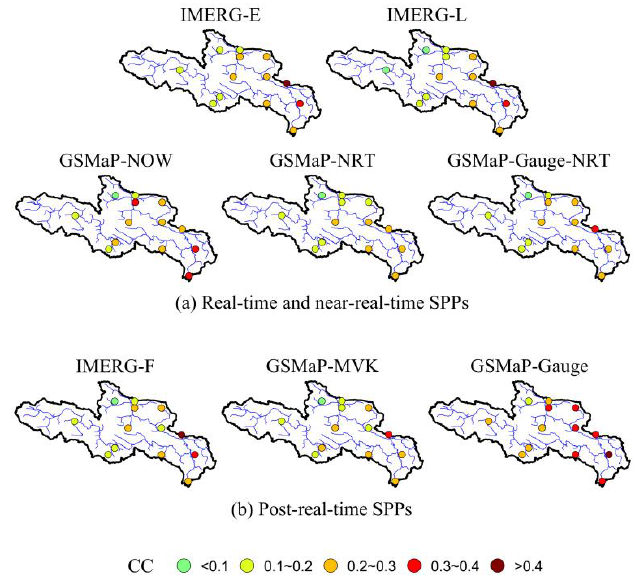
Figure 9. Spatial distribution of CC values at the hourly scale for all eight SPPs: ( a ) Real-time and near-real-time SPPs and ( b ) Post-real-time SPPs.